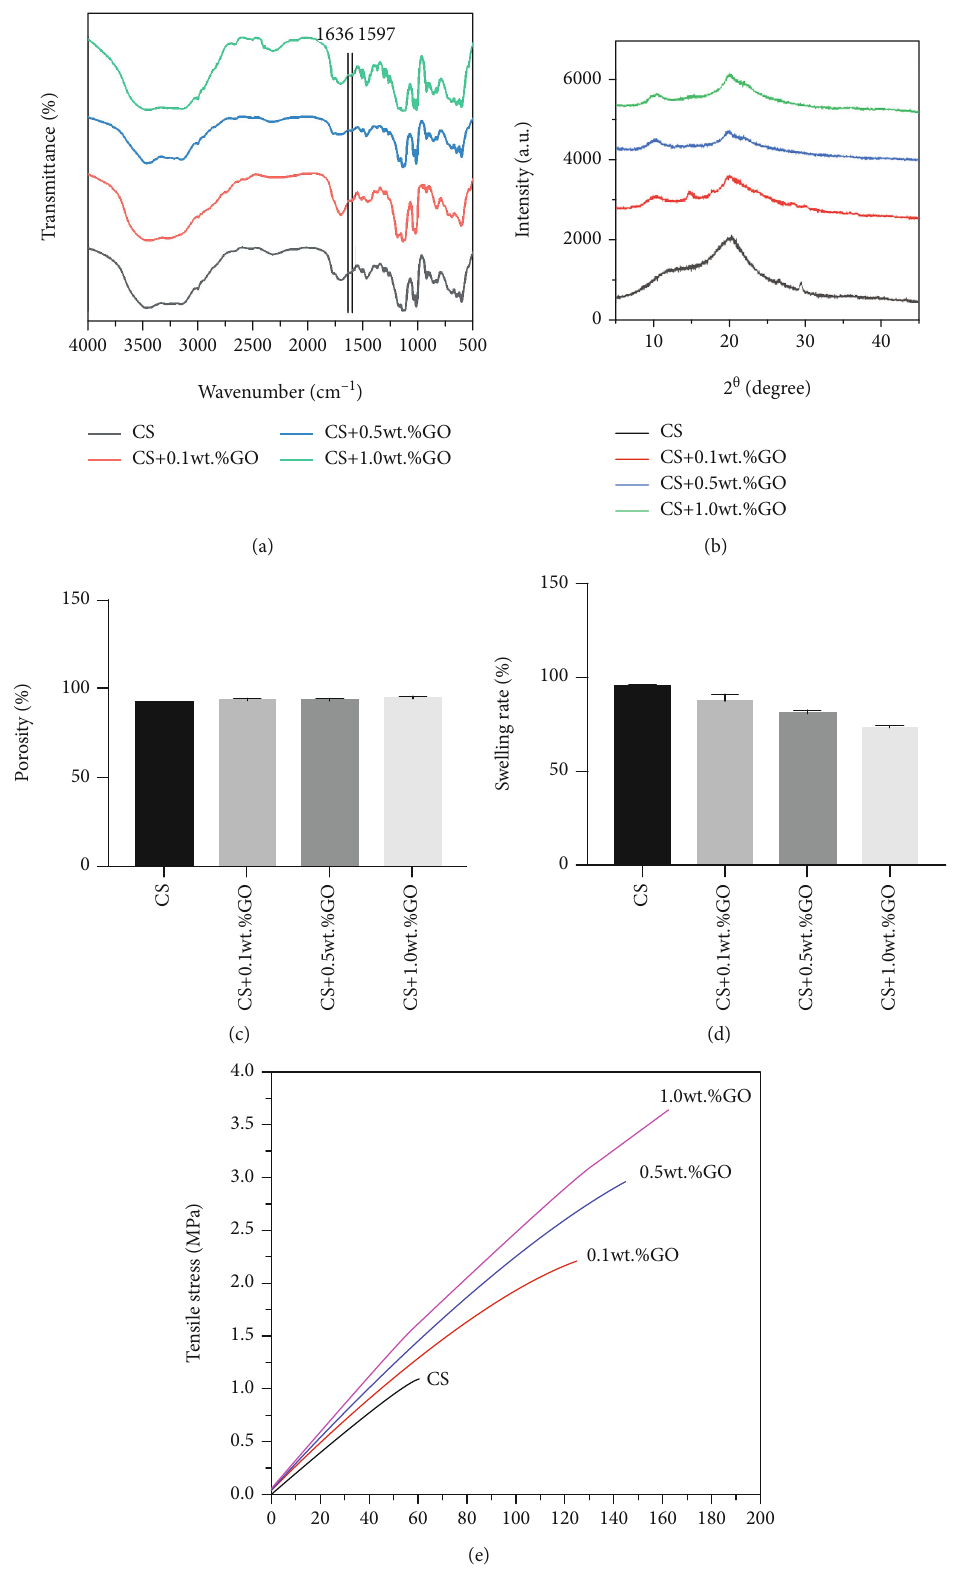
Figure 3: Physical and chemical properties of CS/GO hydrogel sca ff olds. (a) FTIR spectra, (b) XRD patterns, and (c) porosity of the hydrogel sca ff olds of each group ( ∗ P > 0 : 05 ). (d) Swelling rate of the hydrogel sca ff olds of each group ( ∗ P < 0 : 05 ). (e) Tensile properties of the hydrogel sca ff olds of each